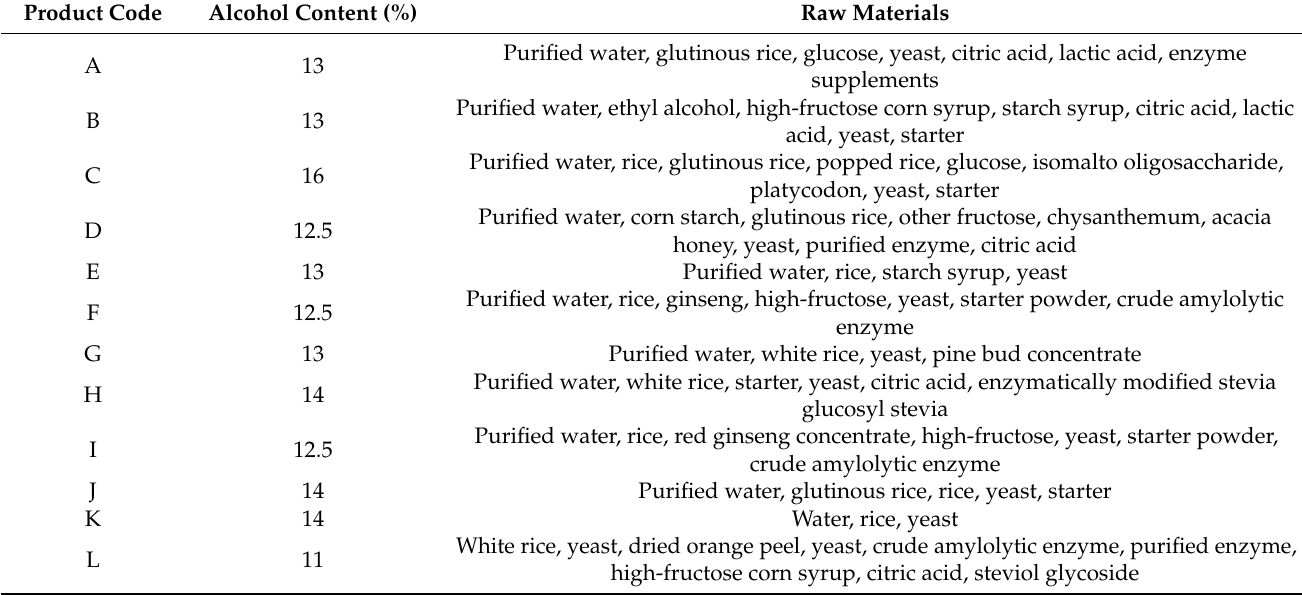
Table 1. Information for the yakju used in this